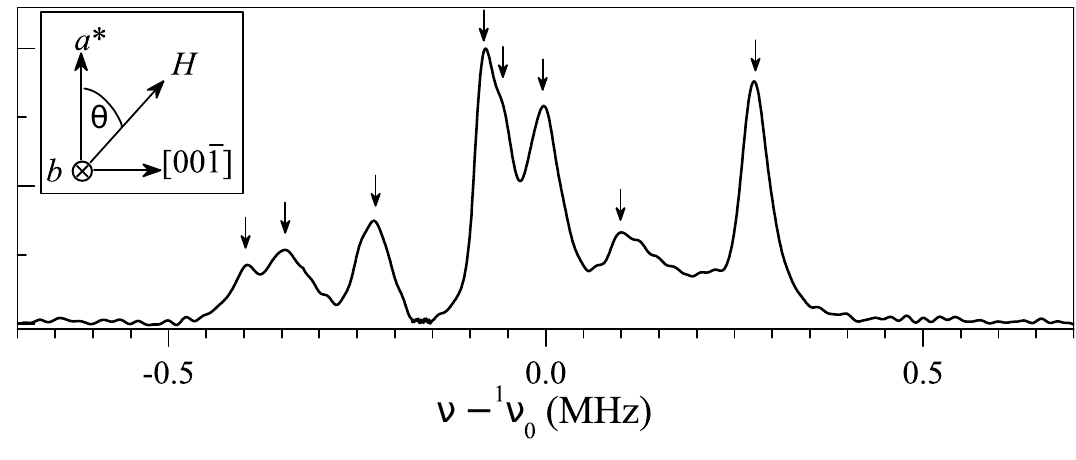
Figure 2. 1 H NMR spectrum in κ -(BETS) oriented at θ = 22 ◦ from ⃗a ∗ towards [00¯1] (= − ⃗c ) direction. The spectrum is shown with respect to 1 ν = 1 γH 0 0